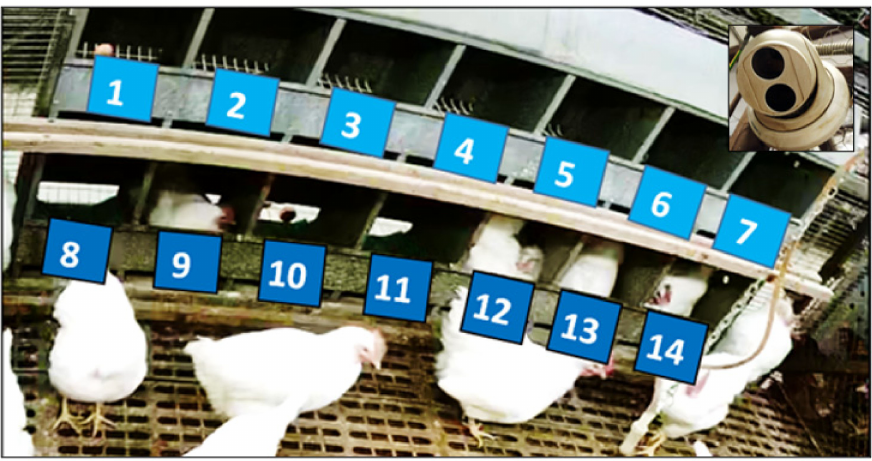
Figure 3. The image taken by an HD camera shows the position of the nests located on two levels in one of the pens installed for the Maternal Line; an infrared camera was installed above the